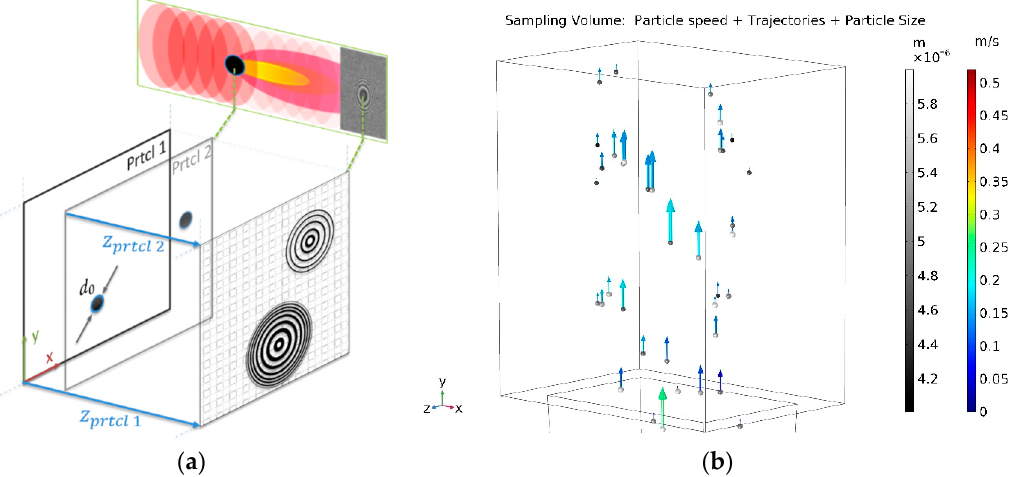
Figure 1. Aerosol particle model of a Holographic Particle Counter: ( a ) Principle In-Line holographic model scheme based on angular spectrum method ( b ) Aerosol Particle